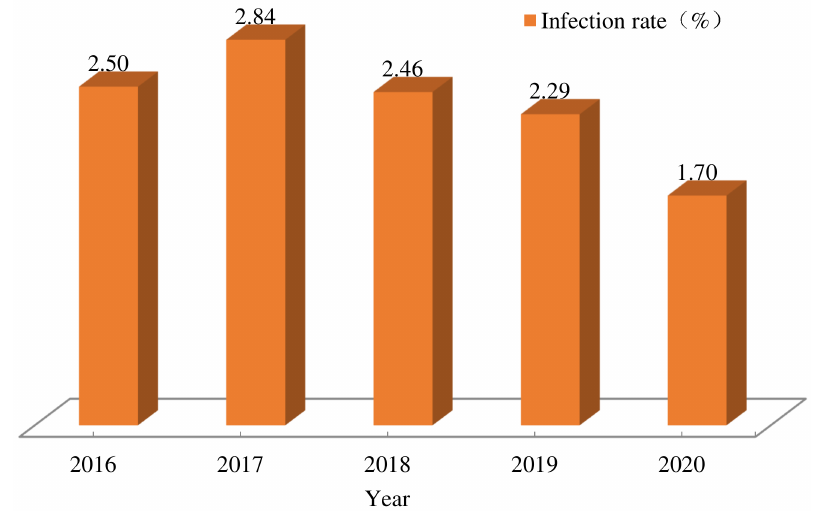
Figure 1. Enterobius vermicularis infections among children aged 3 to 9 years old in China from 2016 to 2020. The differences of the annual infection rates were statistically significant from 2016 to 2020 ( χ 2 = 159.02, P <